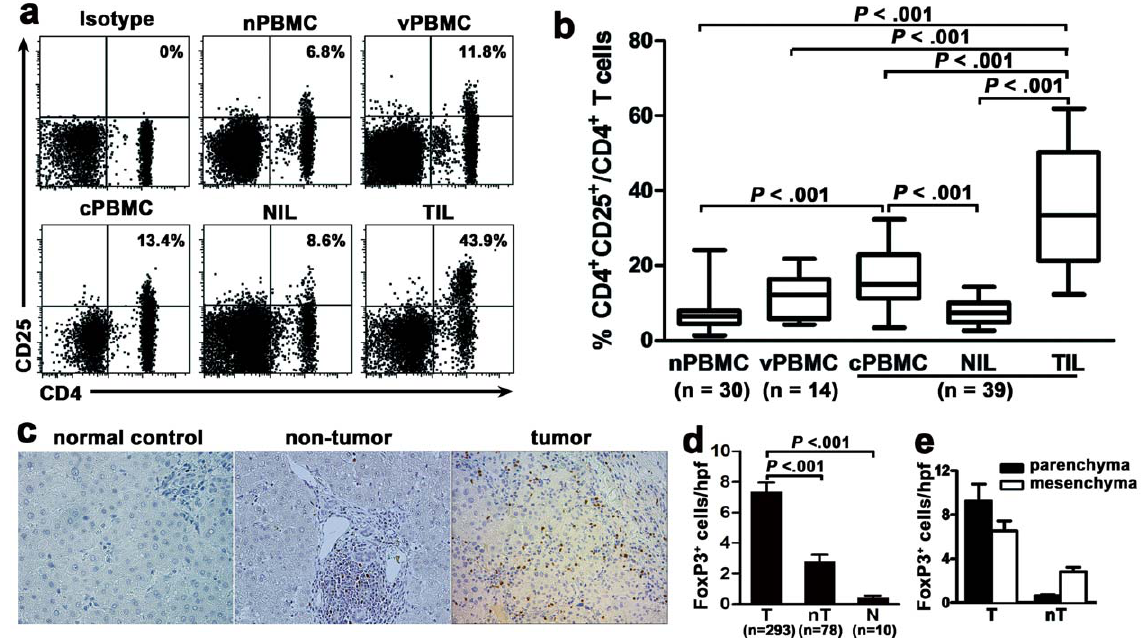
Figure 1. CD4 + CD25 + FoxP3 + Tregs are highly enriched in tumors of HCC patients. Tregs (CD4 + CD25 + T cells) were gated from CD3 + T cells by flow cytometry. (a, b) Representative plots (a) and statistical analysis (b) show that the frequency of CD4 + CD25 + T cells was higher in HCC patients, especially among TIL. The percentages in (a) represent the frequency of CD4 + CD25 + T cells among CD4 + T cells. The data in (b) are expressed in box plots, in which the horizontal lines illustrate the 25th, 50th and 75th percentiles. (c, d) Representative images (c) and statistical analysis (d) of immunohistochemical staining of FoxP3 + lymphocytes in the tumor and non-tumor tissue from HCC patient and normal control liver. Magnification, 6 200. The data in (d) show that the number of FoxP3 + cells is significantly higher in tumor than in non-tumor or normal control. hpf, high-powered field. (e) Statistical analysis shows FoxP3 + cells preferentially aggregate in the parenchyma of tumors.